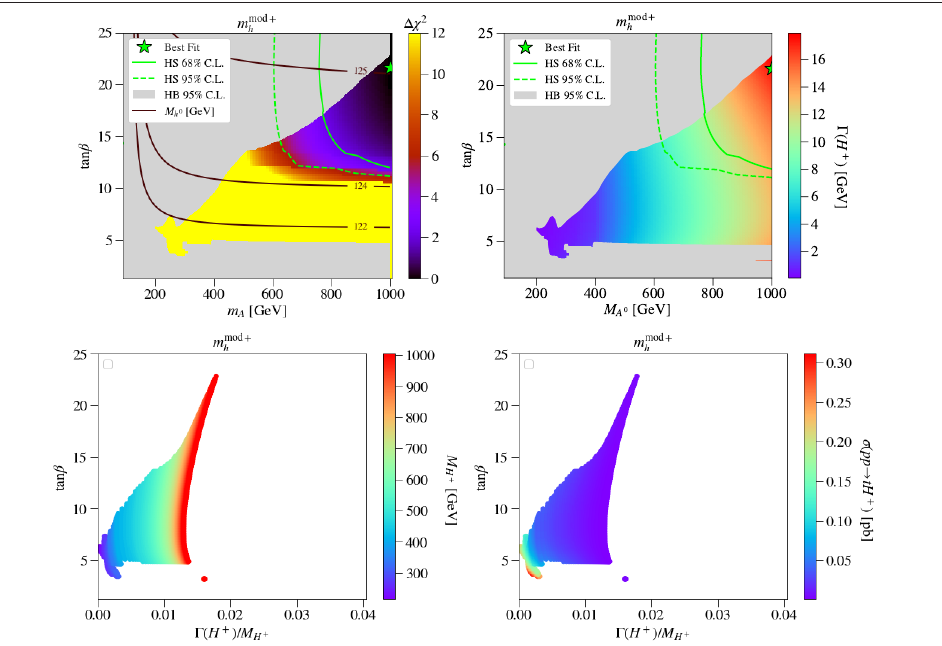
Figure 2. Allowed parameter region in the m mod + scenario over the ( m A ≡ M , tan β ) plane with A 0 h colour showing ∆ χ 2 (top-left) and the charged Higgs boson mass (top-right). The LHC Higgs searches constraints are included. The light green contours are HiggsSignals exclusion limits at 1 σ (solid) and 2 σ (dashed). The light gray area is excluded by HiggsBounds at 2 σ . The solid brown lines are contours for the lighter CP-even scalar h 0 mass. The best fit point is located at M H ± ≈ 1 TeV and tan β = 20. In the two bottom panels of Fig. 2 we present tan β as a function of Γ H ± / M H ± with the colour code showing the charged Higgs mass (left) and the charged Higgs production cross section (right).